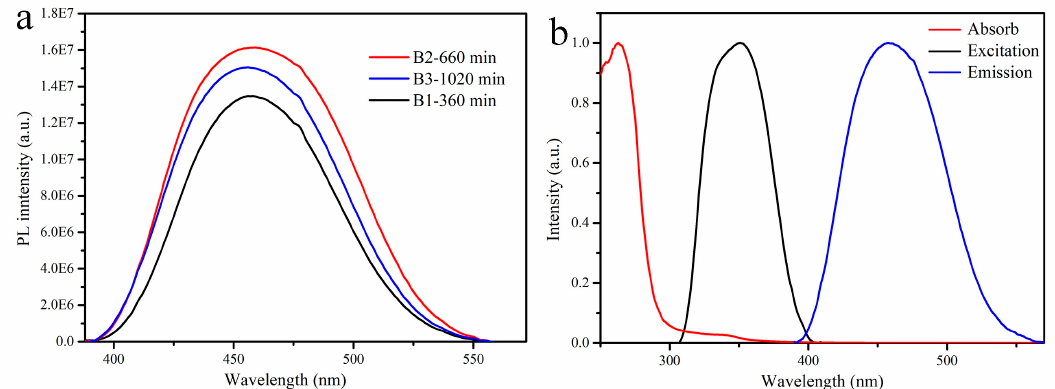
Figure 4. ( a ) The photoluminescence spectra of Ce doped Cs 2 SnCl 6 crystals at di ff erent reaction time; ( b ) the absorption, excitation and emission spectrum of the sample B2.